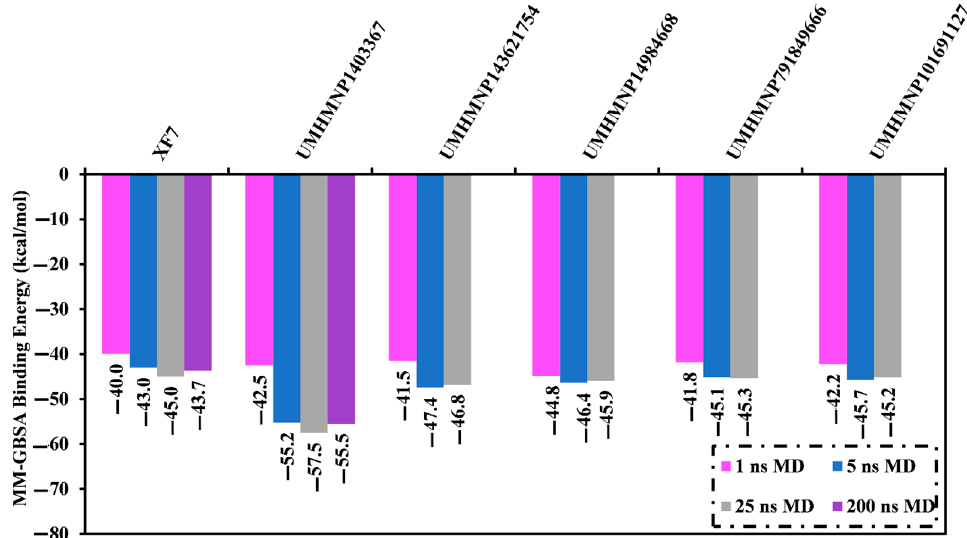
Figure 4. Estimated binding affinities for the five most potent MNPs and the co-crystallized XF7 ligand in complex with 3CL pro over 1 ns in an implicit water solvent and 5, 25, and 200 ns in an explicit water solvent MD.